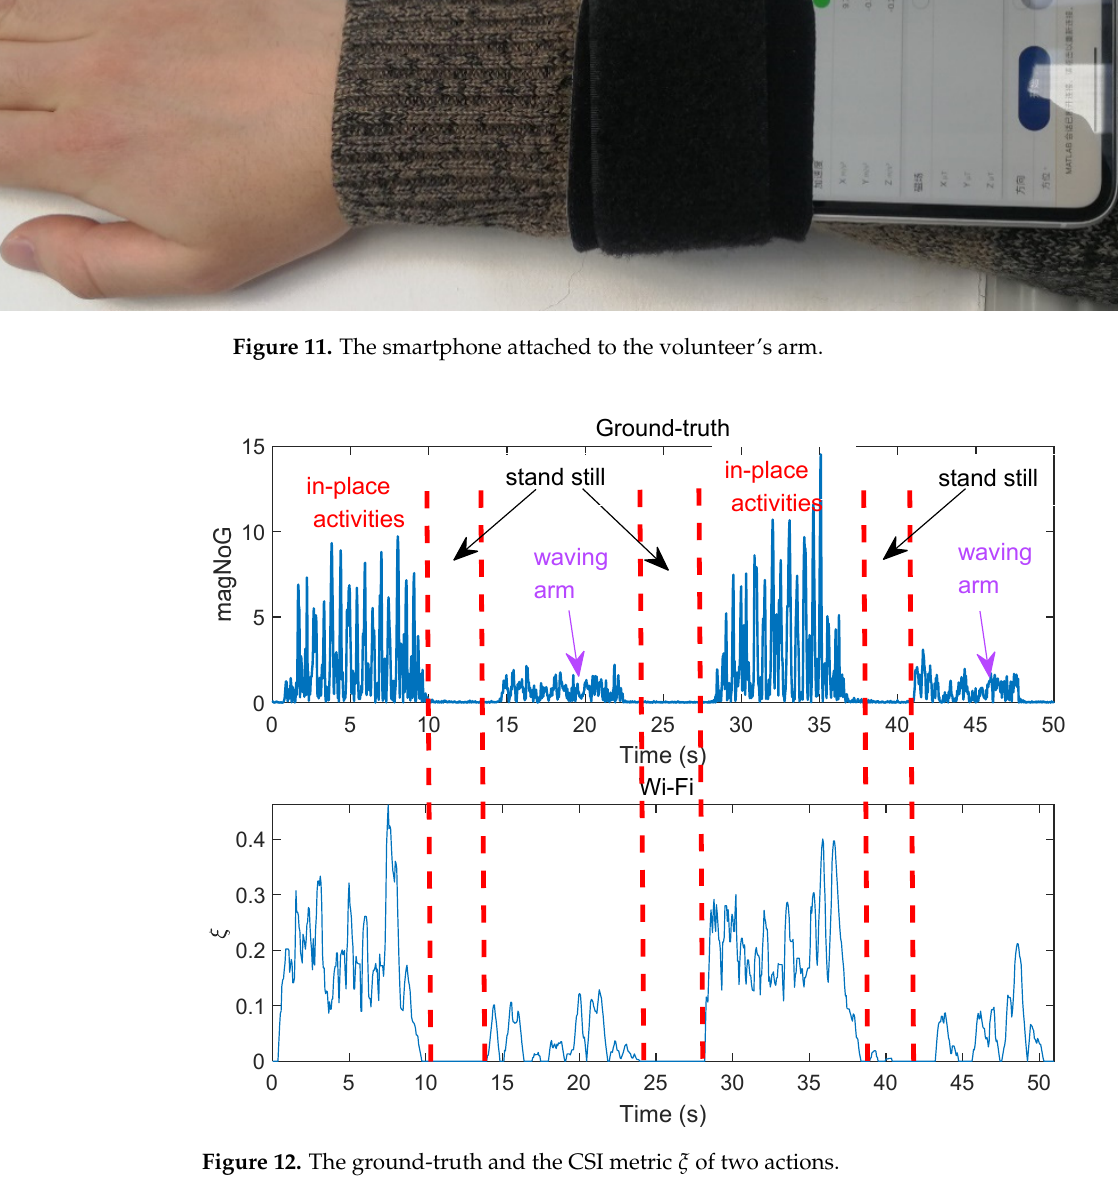
ξ of two actions.